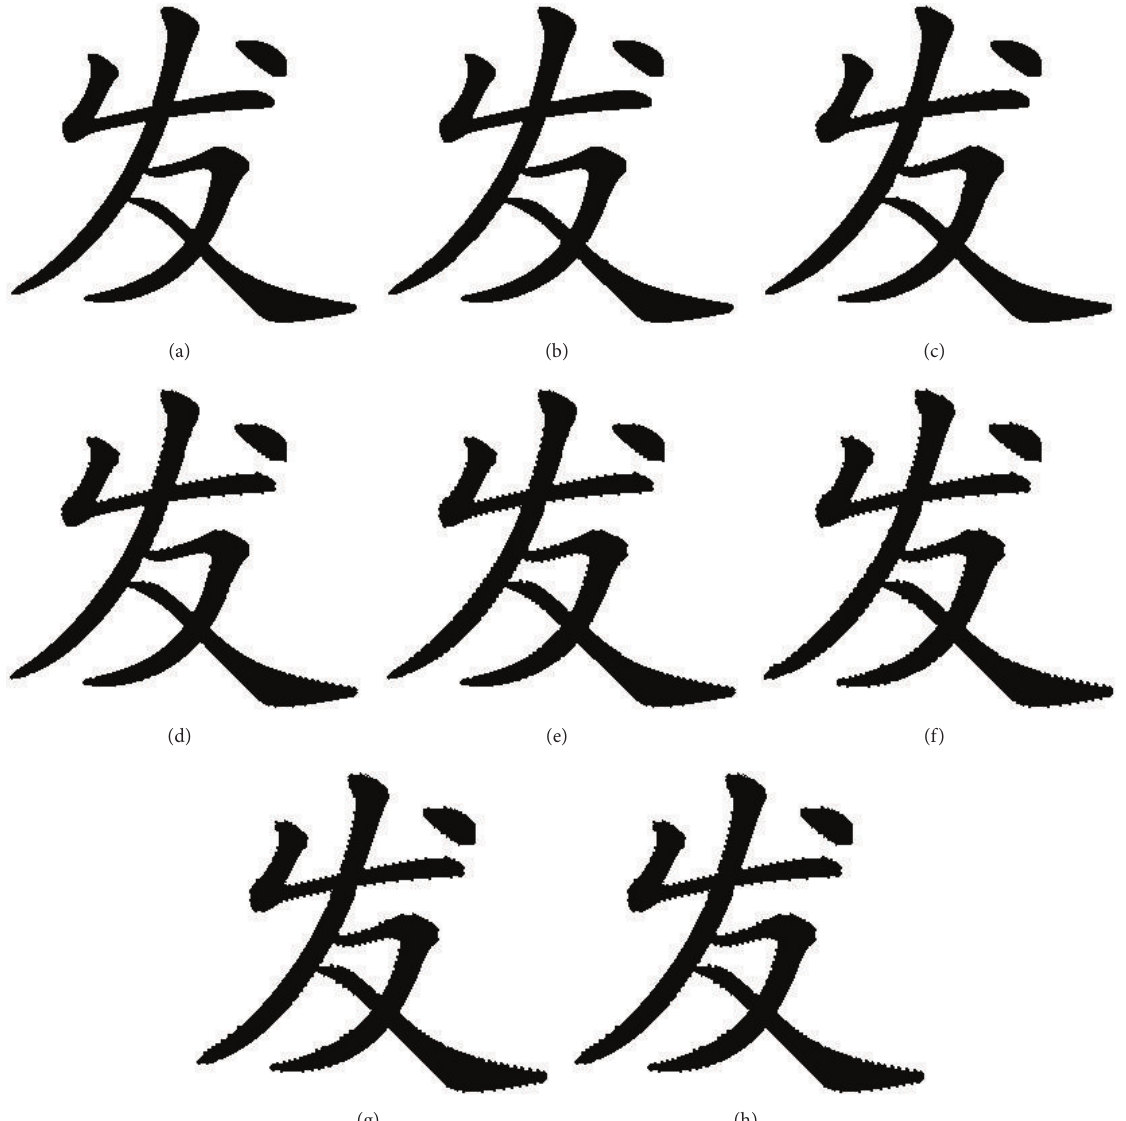
Figure 14: The flipped font binary image using our proposed flipping strategy: (a) flipping 300 pixels; (b) flipping 600 pixels; (c) flipping 900 pixels; (d) flipping 1200 pixels; (e) flipping 1500 pixels; (f) flipping 1800 pixels; (g) flipping 2100 pixels; (h) flipping 2400